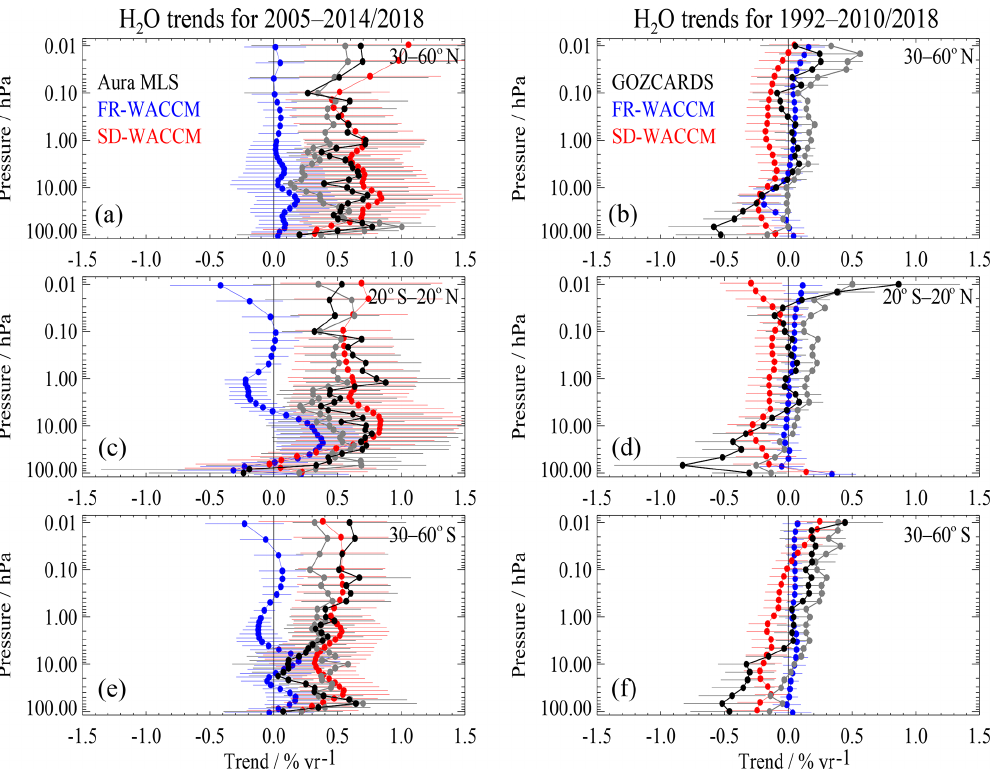
Figure 22. Trends in three latitude bins for stratospheric and mesospheric H 2 O from an analysis of the 2005–2014/2018 MLS data and the two WACCM models for 2005–2014/2018 (a, c, e) and the 1992-2010/2018 time period (b, d, f) ; only the observational trend results are extended through 2018 (grey points) for MLS (a, c, e) and for GOZCARDS (b, d, f)